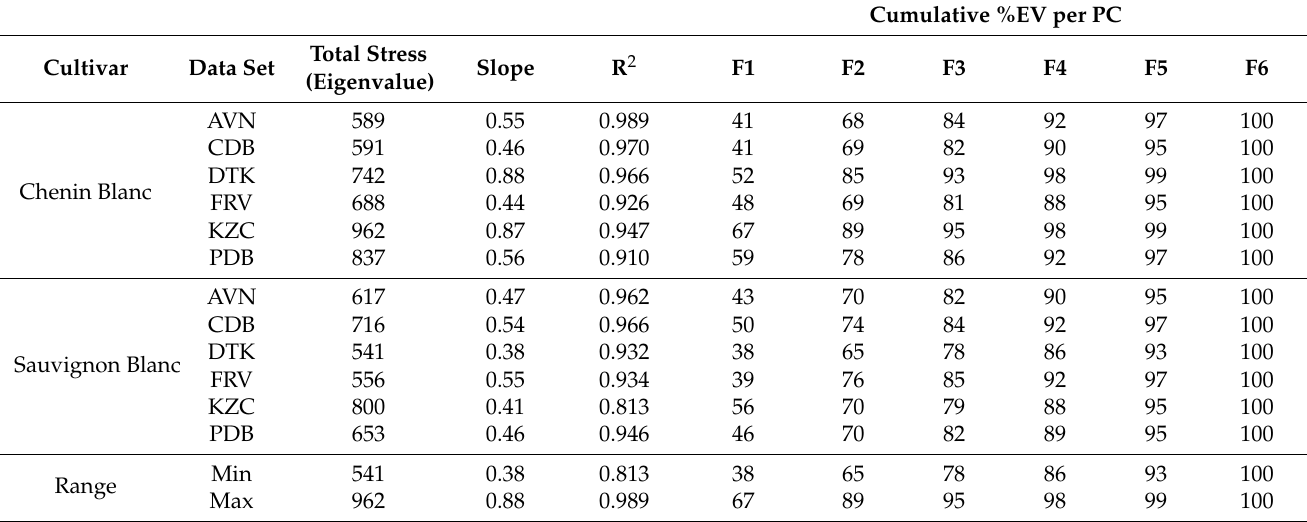
Cumulative %EV per